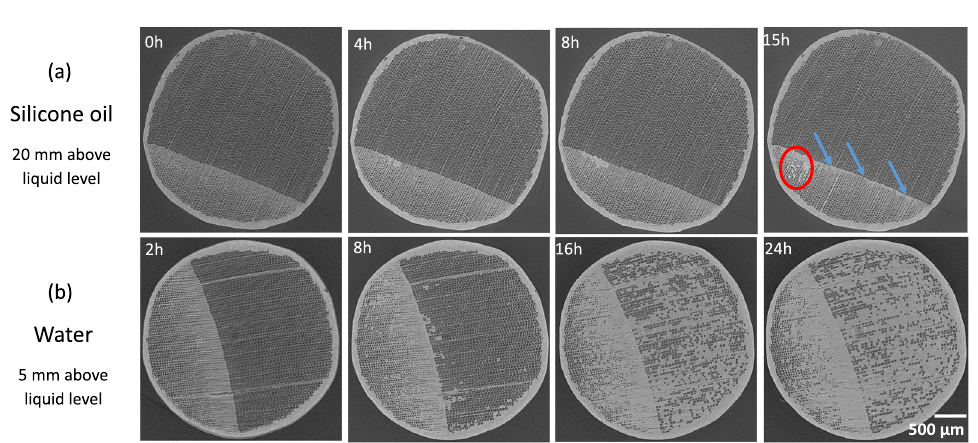
Figure 6. Cross-sections of spruce obtained by tomography at different times during imbibition experiments: (top) with silicone oil and (bottom) with